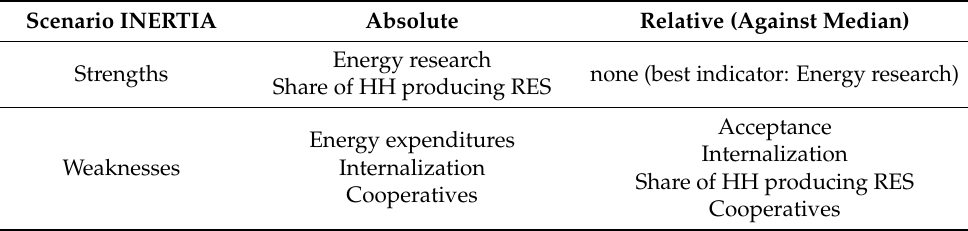
Table 4. Strength and weakness of scenario INERTIA with respect to the non-model-based indicators. Scenario